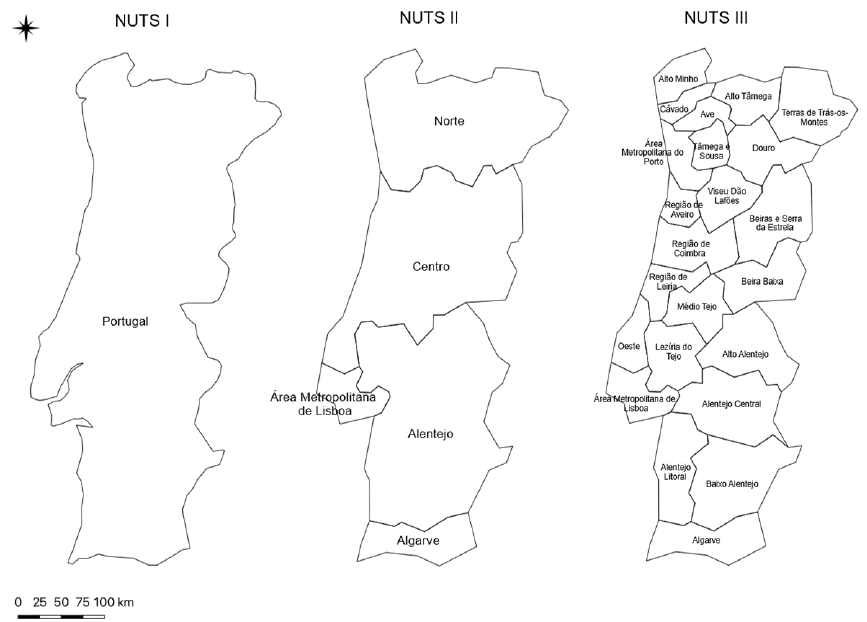
Figure 1. Mainland Portugal NUTS